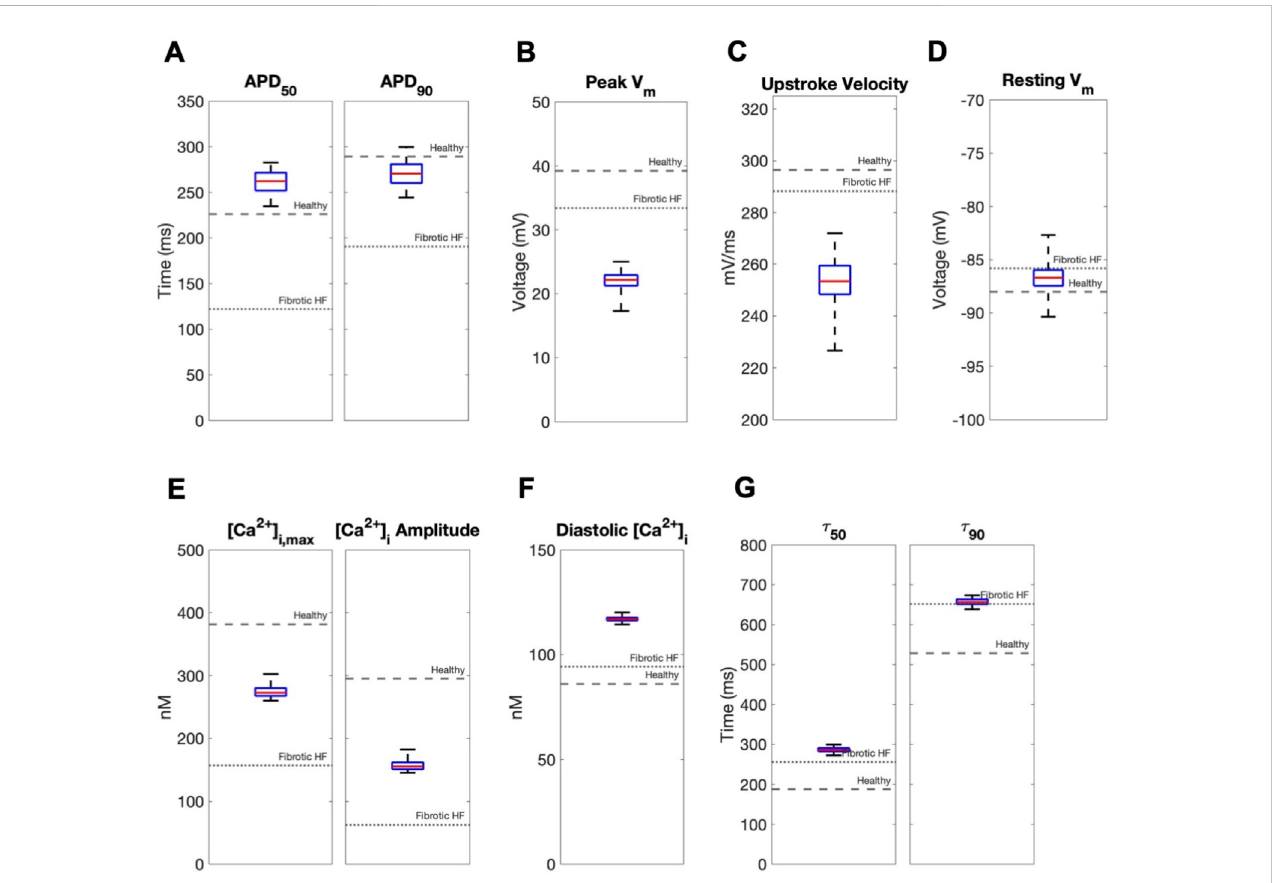
FIGURE 3 Effectsofacceptedcustomcellheterocellularcouplingon fi broticheartfailurecardiomyocyteelectrophysiologyandcalciumhandling.Actionpotential andcalciumtransientmetricsof fi broticheartfailure(HF)cardiomyocyteswhencoupledtoacceptedcustomcellsareshownasboxandwhiskerplots.Action potential metrics include: (A) Action potential duration (APD) at 50% repolarization (APD 50 ) and 90% repolarization (APD 90 ); (B) peak voltage; (C) upstroke velocity; and (D) resting membrane potential. Calcium transient metrics include: (E) peak intracellular calcium and calcium transient amplitude; (F) diastolic calcium; and (G) calcium relaxation time constant at 50% decay ( τ 50 ) and 90% decay ( τ 90 ). Values for untreated healthy and fi brotic HF cardiomyocytes are shown as dashed and dotted lines,